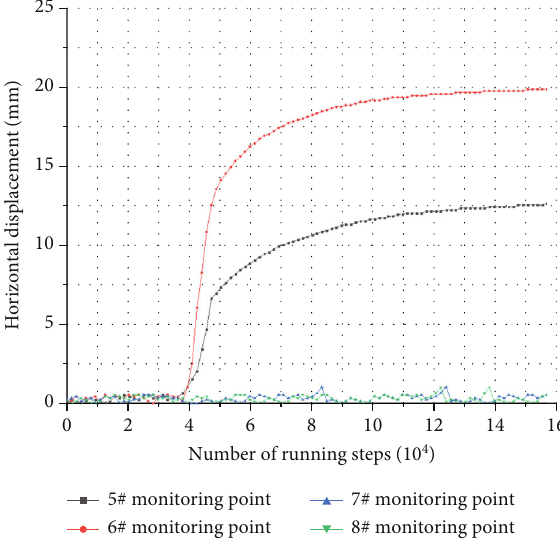
Figure 18: Horizontal displacement change of the slope foot monitoring